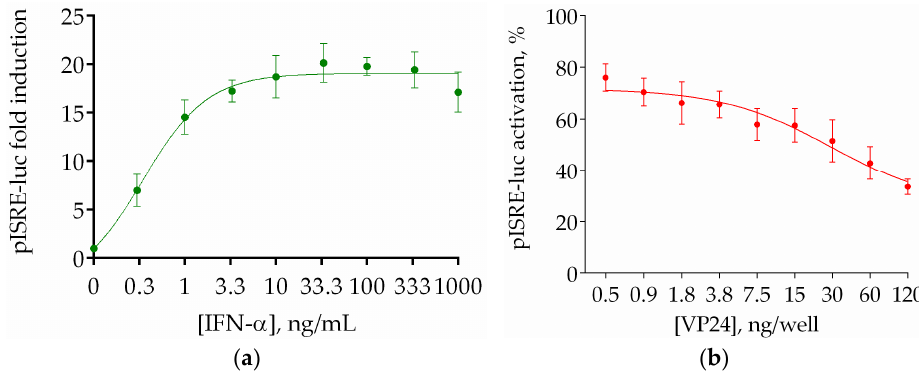
Figure 3. ( a ) HEK293T cells were transfected with pISRE ‐ luc (60 ng/well), RL ‐ TK (10 ng/well), and pcDNA3.1 (30 ng/well). Twenty ‐ four hours after transfection, cells were stimulated with different concentrations of IFN ‐α between 0.3 and 1000 ng/mL or left unstimulated. The medium was changed after 8 h, and luciferase activity was measured. Results are shown as pISRE ‐ luc fold induction of stimulated cells over not stimulated control. Firefly luciferase activity is normalized to the Renilla luciferase internal control. Error bars indicate the mean ± SD; ( b ) Regression curve of VP24 inhibition was obtained transfecting HEK293T cells with reporter vector at the fixed concentration of 60 ng/well, RL ‐ TK (10 ng/well), and EBOV VP24 ‐ FLAG or empty vector in concentrations between 0.5 and 120 ng/well. Results are shown as percentage of pISRE ‐ luc activation in VP24 transfected cells over empty vector transfected controls. Firefly luciferase activity is normalized to the Renilla luciferase internal control. Error bars indicate the mean ± SD.